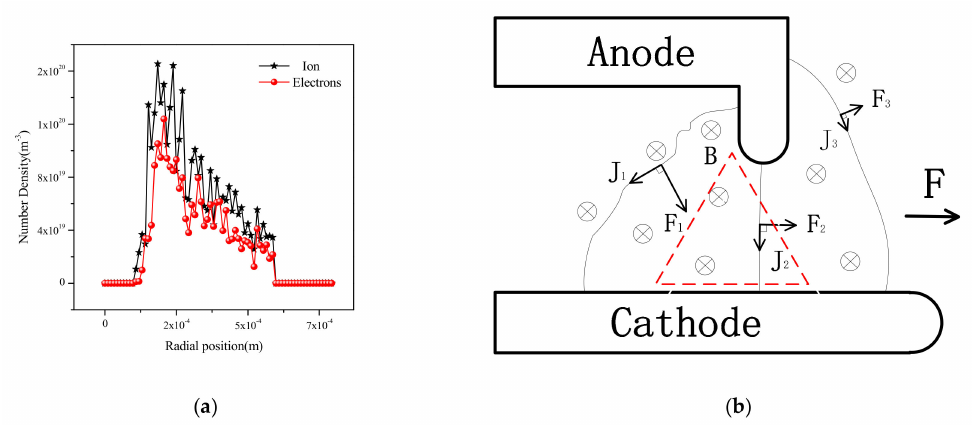
Figure 4. Distribution curve of the charged particle number density interelectrode ( a ) and the relationships among current, magnetic field, and thrust ( b ), (400 A, 100 V, 4 g / s).